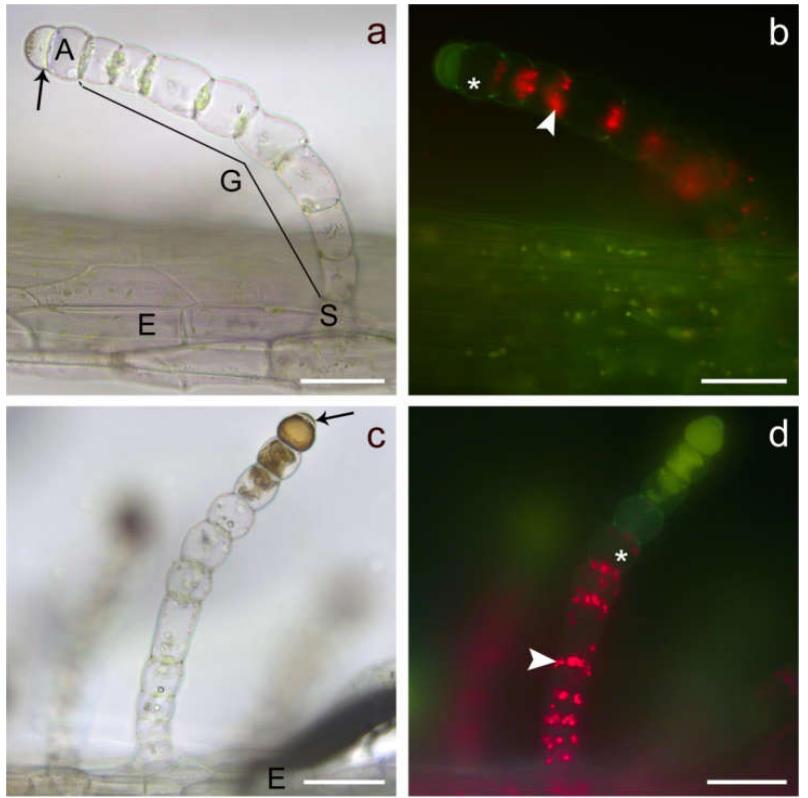
Figure 1. Light ( a , c ) and fluorescence ( b , d ) microscopic images of fully developed linear glandular trichomes from the stem epidermis in the early secretory stage ( a , b ) and from leave veins ( c , d ) in an advanced secretory stage. The trichomes consisted of a basal cell (obscured here) anchored in the epidermis (E), followed by a stalk cell (S) and 6–10 barrel-shaped glandular cells (G) with large vacuoles and plastids (white arrowheads). A mostly rounded apical cell (A) which could show irregular protuberances of subcuticular spaces (black arrows) formed the tip of the trichome. Cell which have lost vitality are marked by a star. Scale bar = 50 µm.